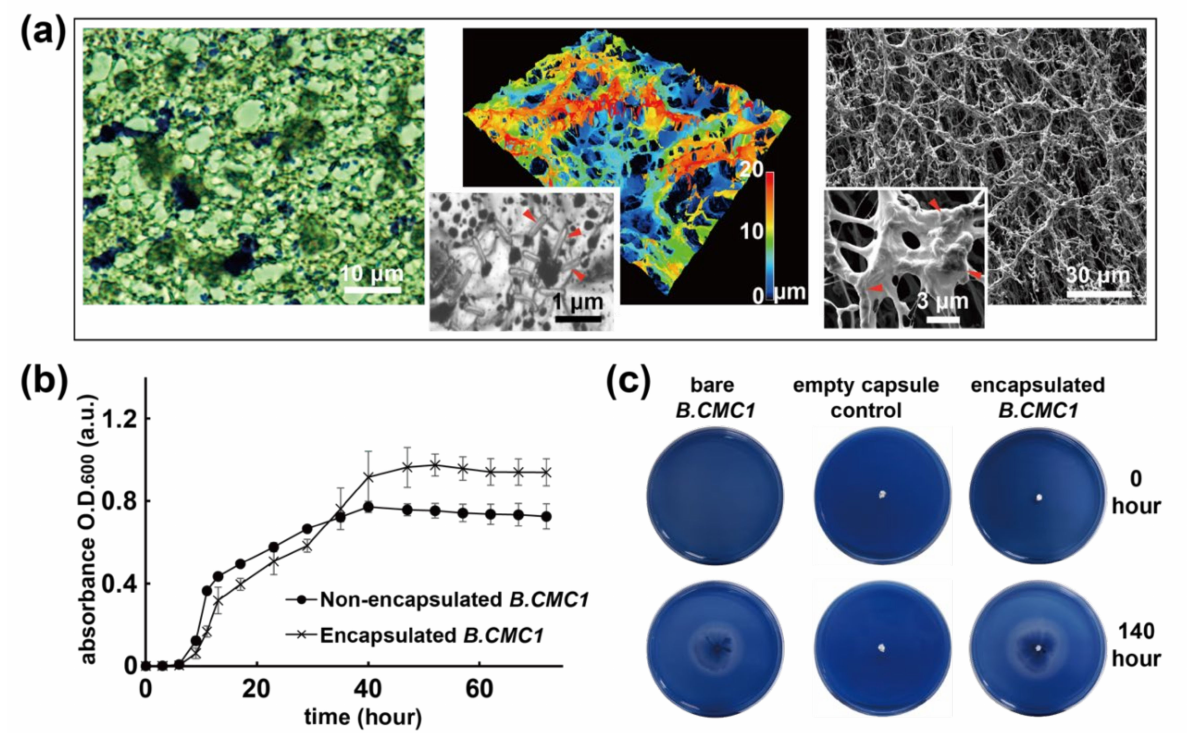
Figure 2. Viability analysis of B. CMC1 activities of the fabricated capsule. ( a ) Micrographs showing stained (crystal violet, purple color), 3-D structural, and SEM topological images of encapsulated B. CMC1 within the capsule products. The yellow marks indicate the presence of B. CMC1 within the polymer structure. ( b ) Bacterial growth curves and ( c ) enzymatic functions were compared in parallel for pure bacteria to verify